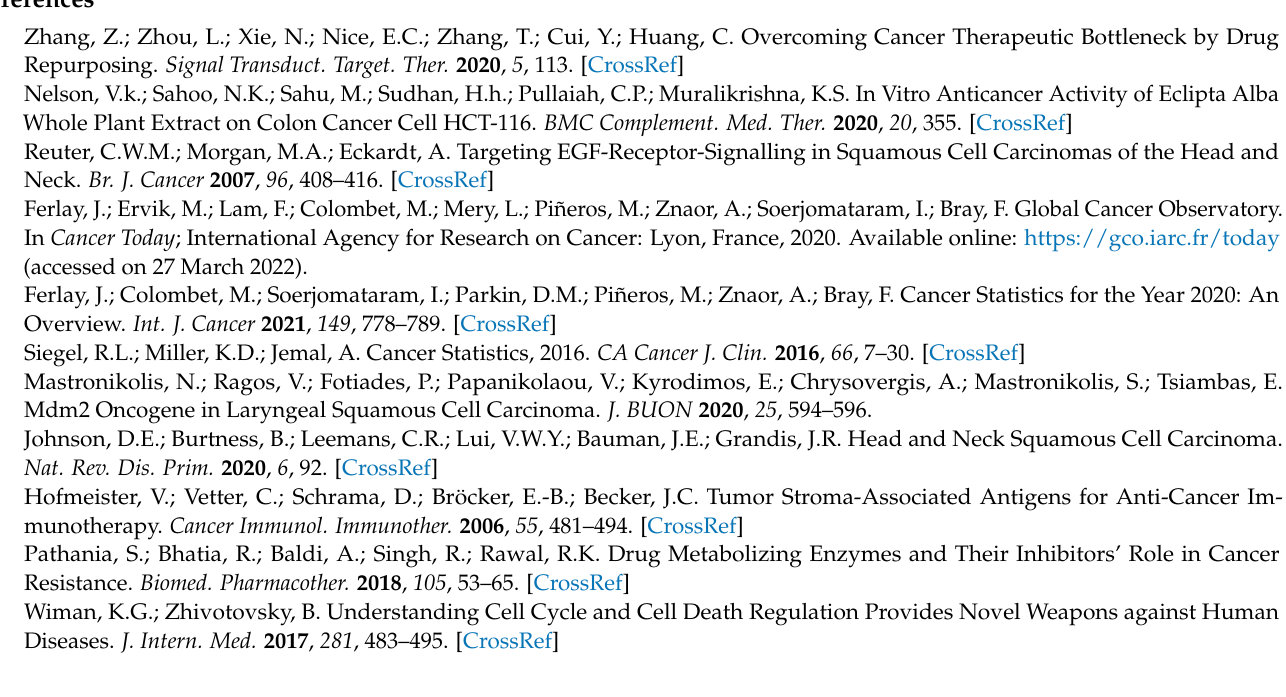
CDCl 3 ; Figure S2: 13 C NMR spectrum of BP in CDCl 3 ; Figure S3: 1 H NMR spectrum of BN in CDCl 3 ; Figure S4: 13 C NMR spectrum of BN in CDCl 3 ; Figure S5: 1 H NMR spectrum of EP in CDCl 3 ; Figure S6: 13 C NMR spectrum of EP in CDCl 3 ; Figure S7: 1 H NMR spectrum of EN in CDCl 3 ; Figure S8: 13 C NMR spectrum of EN in CDCl 3 ; Figure S9: HRMS spectrum of BP; Figure S10: HRMS spectrum of BN; Figure S11: HRMS spectrum of EP; Figure S12: HRMS spectrum of EN; Figure S13: Molecular simulation dynamics of CYP1A2 (Grey) and DYRK1A (Red) protein and ligand BP. (A) Minimum distance and (B) total interaction around 3.5 Å of CYP1A2 and DYRK1A protein relative to the starting complexes during 10,000 ps MD test; Figure S14: Energetic components by MD simulation show a better interaction of BP with CYP1A2 than with